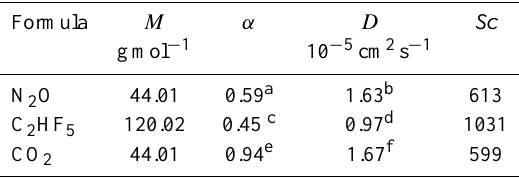
Table 2. Chemical and physical properties of the trace gases used, nitrous oxide (N 2 O) and pentafluoroethane (C 2 HF 5 ), as well as for carbon dioxide (CO 2 ) for comparison. All values are given at 20 ◦ C for freshwater. Given Schmidt numbers are calculated using Sc